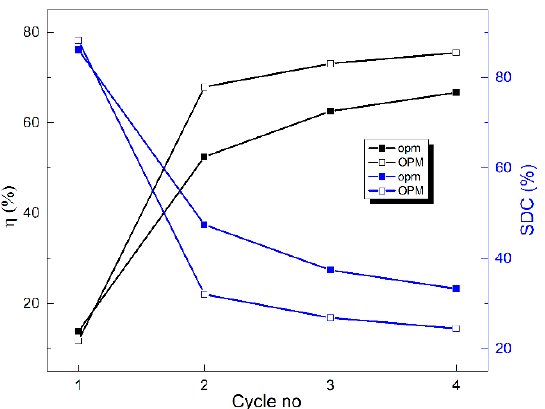
Figure 4. Evolution of energy-storage efficiency ( η ) and specific damping capacity ( SDC ) with the number of loading–unloading cycles according to Figure 3b,c.